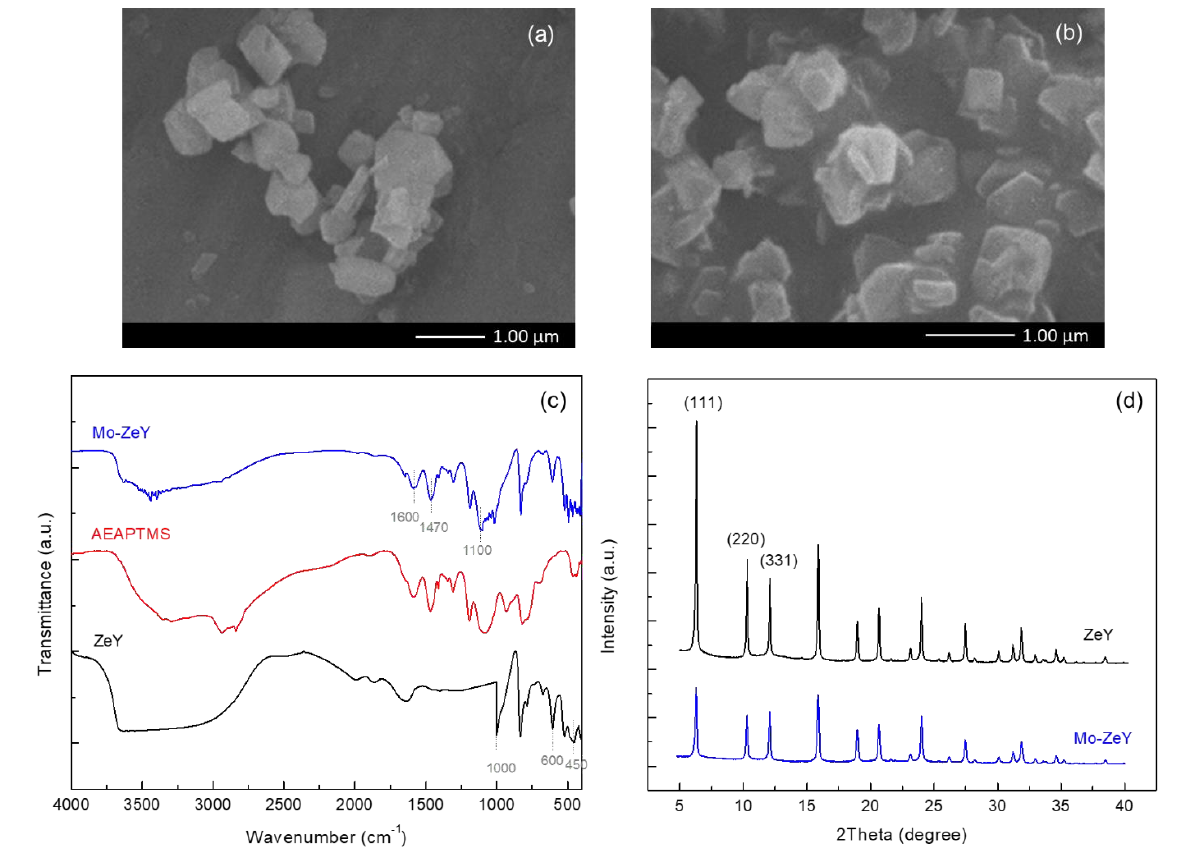
Figure 2. SEM images of ( a ) Pristine zeolite Y (ZeY) and ( b ) Modified zeolite Y (Mo-ZeY) with aminosilane and their corresponding ( c ) ATR-FTIR spectra and ( d ) XRD patterns.